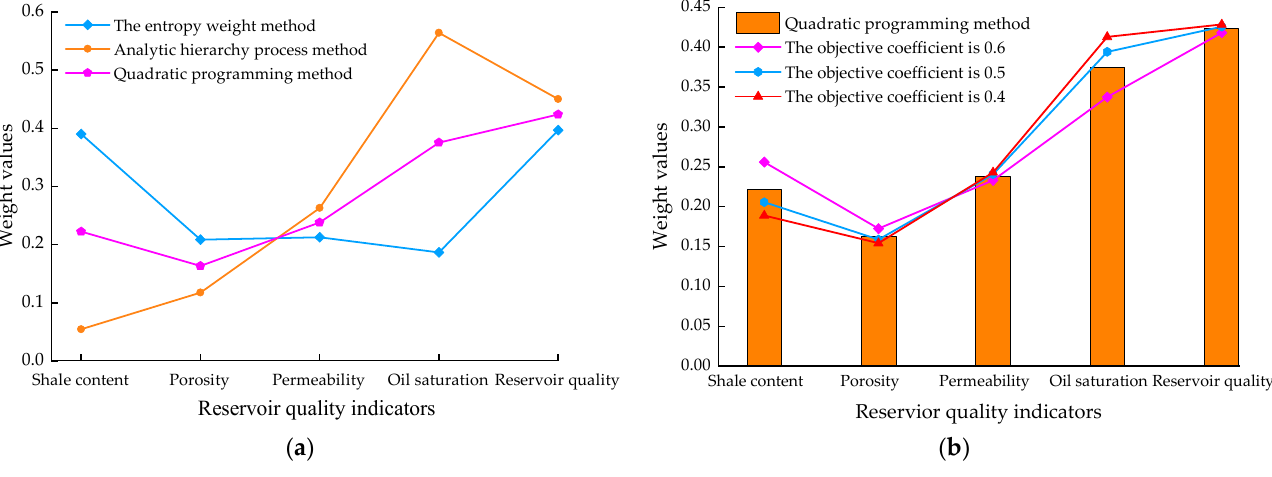
Figure 2. Weight values of reservoir quality: ( a ) comparison between EWM, AHP, and quadratic programming; ( b ) comparison between linear combination weighting and quadratic programming method.